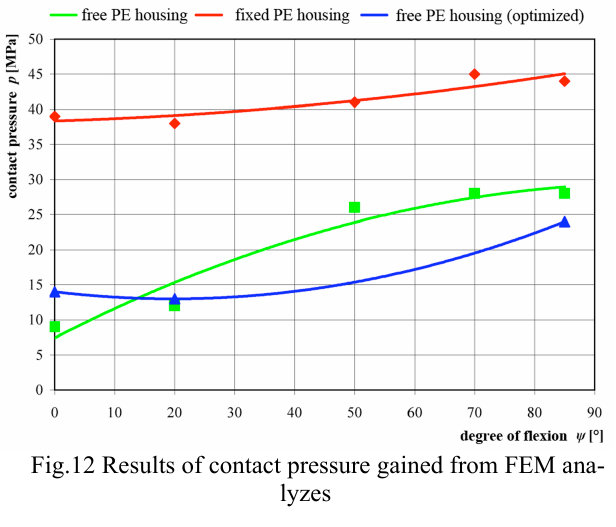
Fig.12 Results of contact pressure gained from FEM ana-